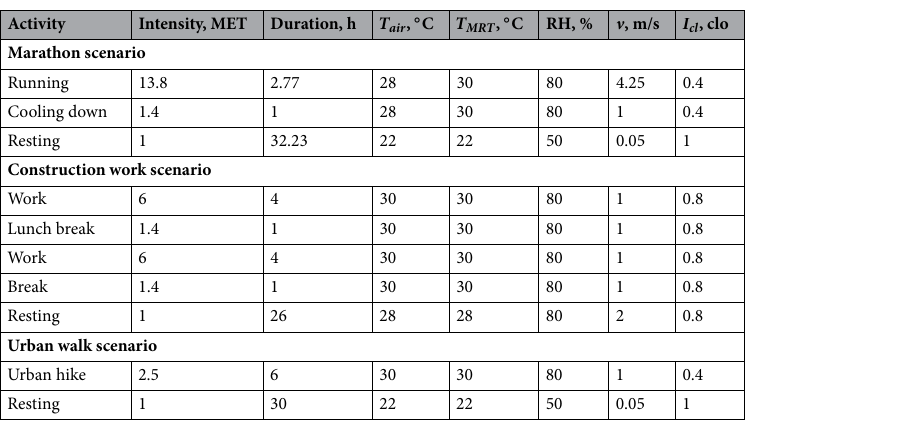
Table 2. The schedule of three activity